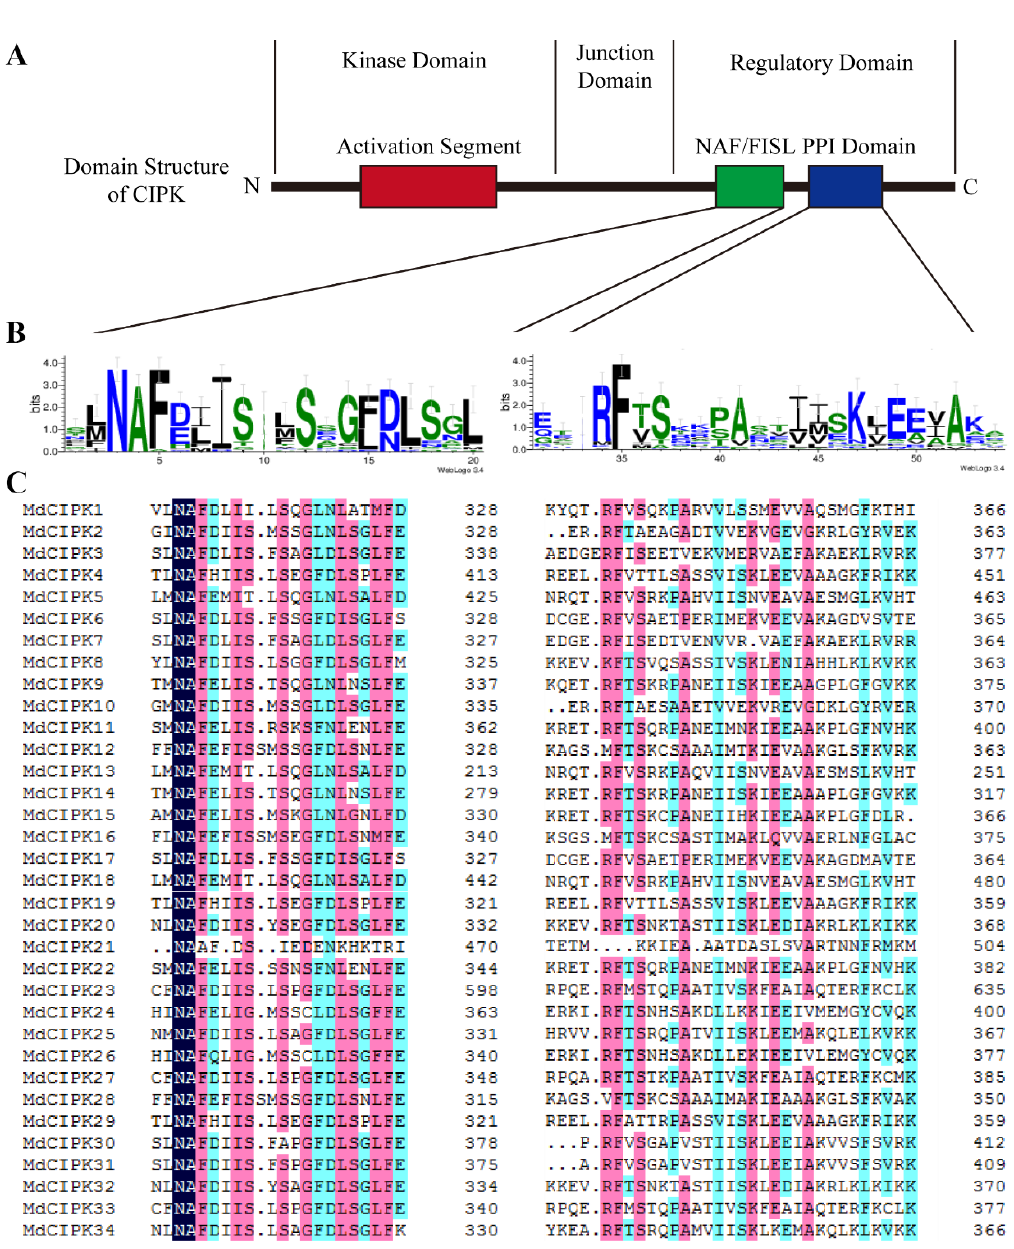
Figure 1. CIPK domains in the MdCIPK proteins. ( A ). The conserved domains were identified using the MEME suite. ( B ). The overall height in each stack indicates the sequence conservation at each position. Each residue letter height is proportional to the relative frequency of the corresponding residue. ( C ). The CIPK domain of each group was compared use the DNAMAN 7.0 software and conserved amino acid residues are shown in dark blue. Sequences highlighted in dark blue, red, and light blue indicate homology =100%, ≥ 75%, and ≥ 50%, respectively.